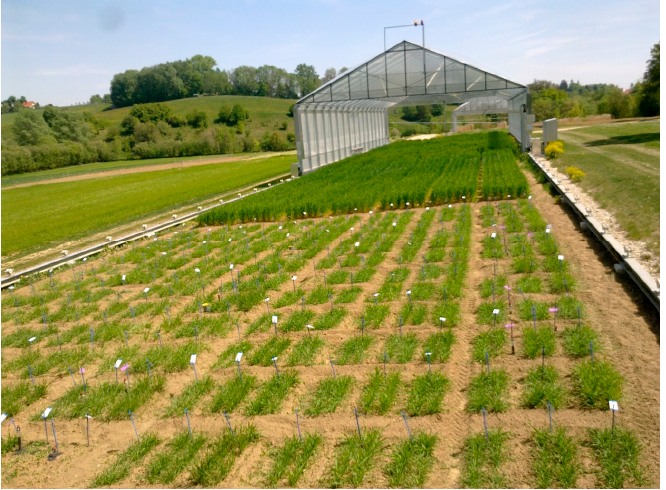
Figure 1. Field trials within a rain-out shelter platform, illustrating different row designs for spring barley grown in two rows ( foreground ) and for winter barley grown in six rows ( background ).